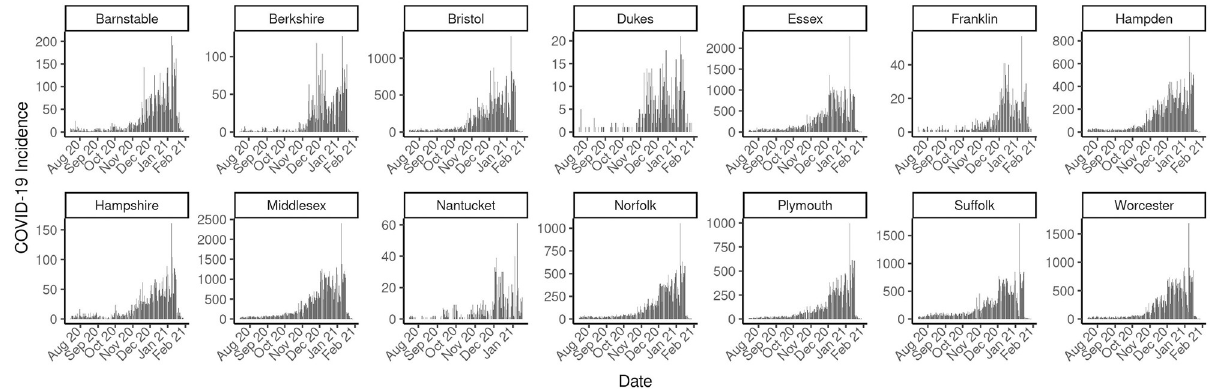
Fig 3. Reported Incidence for all MA counties. Incidence of COVID-19 from July 1 st , 2020 to February 28 th , 2021 for the 14 counties in the State of Massachusetts, USA.